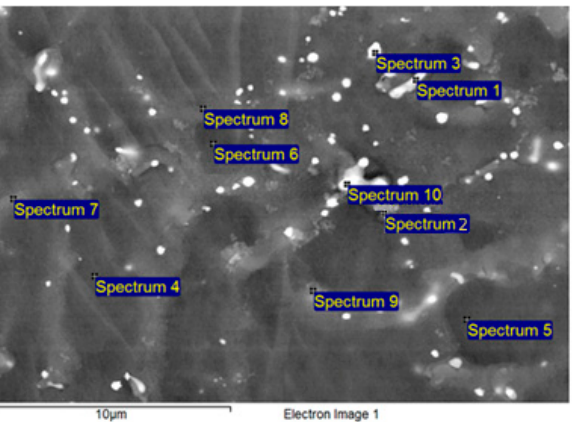
Figure 8. Local chemical composition measurement sites using EDS analysis in the weld no. 1.